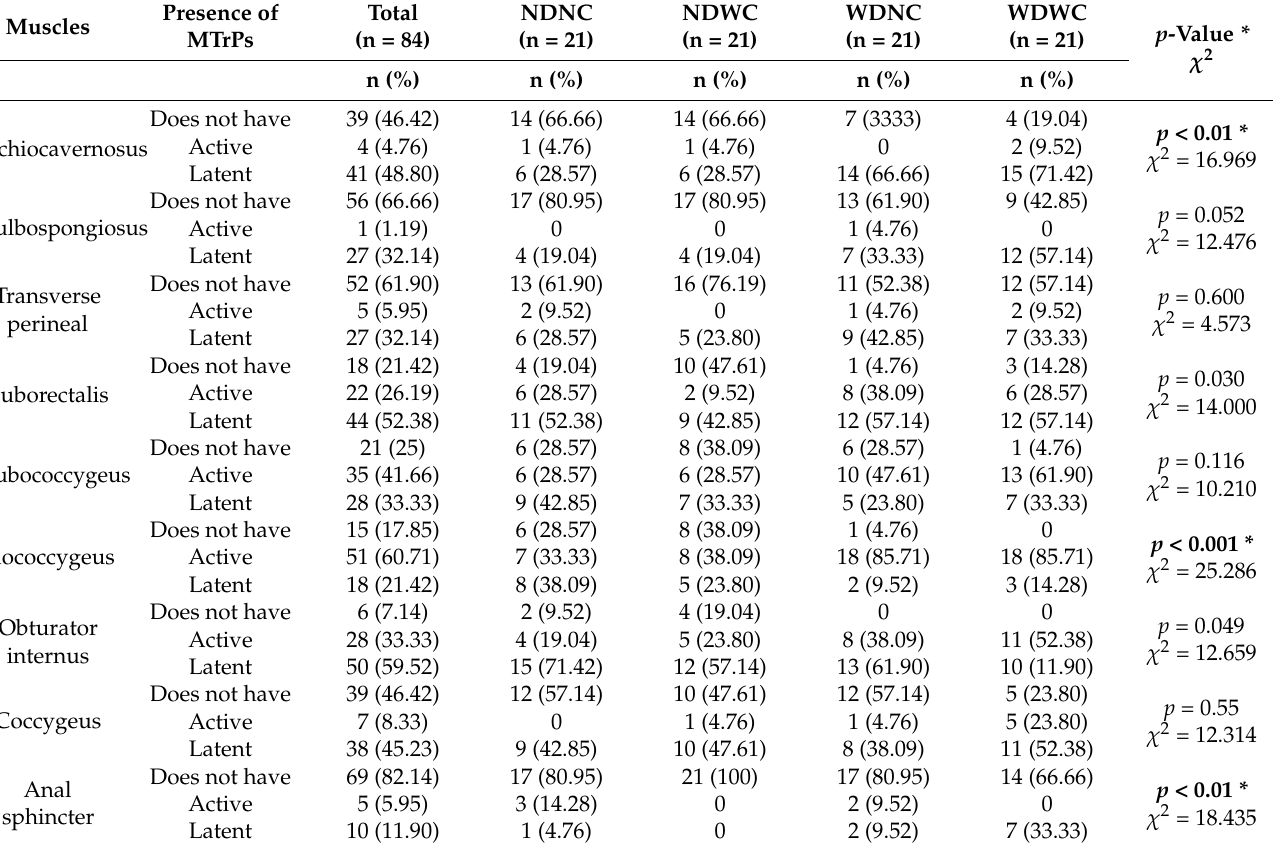
Table 8. Presence of MTrPs in the pelvic floor muscles evaluated in the ovulatory